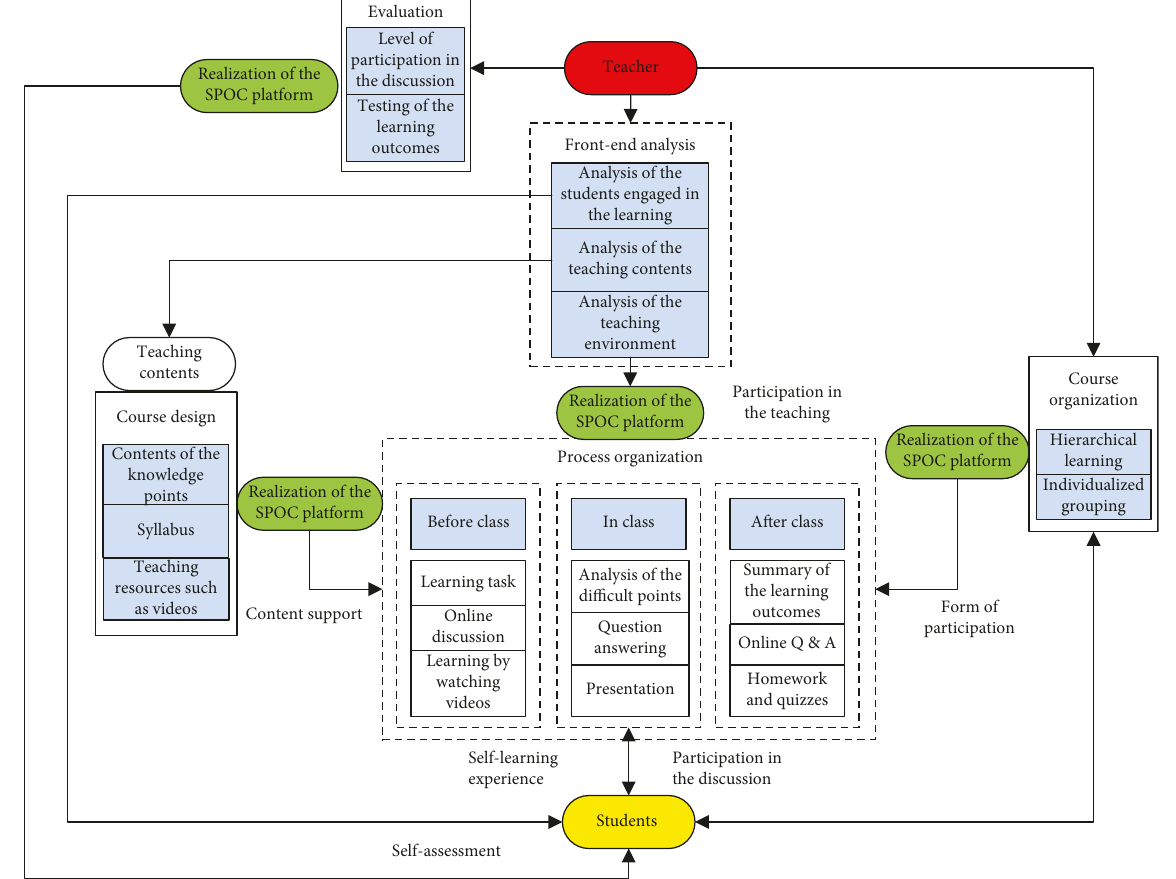
Figure 1: In the postpandemic era, the design of the blended teaching mode is based on the SPOC platform. Table 1: Table of thematic decomposition of the Operating System Principle and Practice course. Windows server configuration and